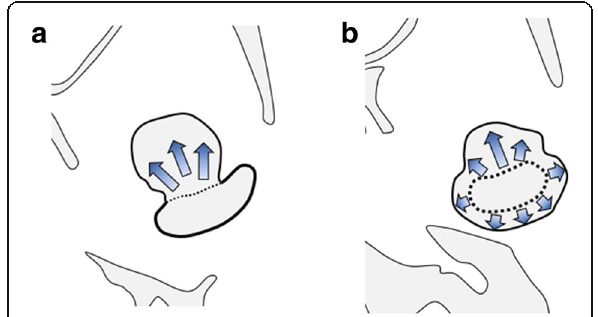
Fig. 1 Classifications of osteochondroma. a Type 1 osteochondroma –